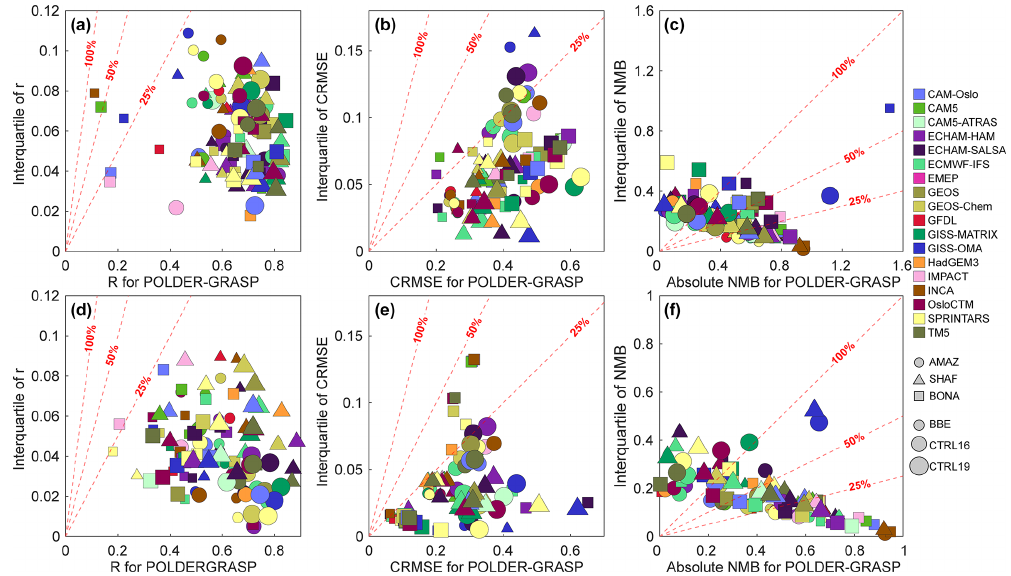
Figure 3. Variation in model AOD evaluation due to different choices of satellite products in terms of the correlation coefficient (a, d) , centered root mean square error (b, e) , and normalized mean bias (c, f) . The results are shown as comparisons between the values using POLDER-GRASP (horizontal axis) and interquartile ranges (vertical axis) when validating each model with different satellite products. The top (a–c) and bottom (d–f) panels show the results for individual and synchronous collocation, respectively. The color, shape, and size of dots indicate different models, three fire regions, and three AeroCom experiments, respectively. The dashed lines show the 25%, 50%, and 100% slopes (the interquartile relative to POLDER-GRASP). The GISS-OMA data for BBE over BONA are not shown in (b) due to the very high